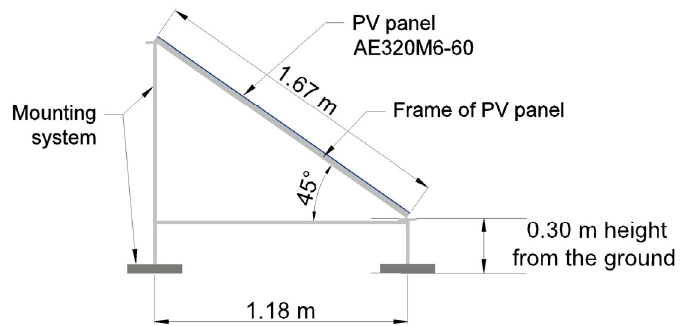
Figure 4. Side view of the set-up of the fixed PV panel, inclined at 45 ◦ .